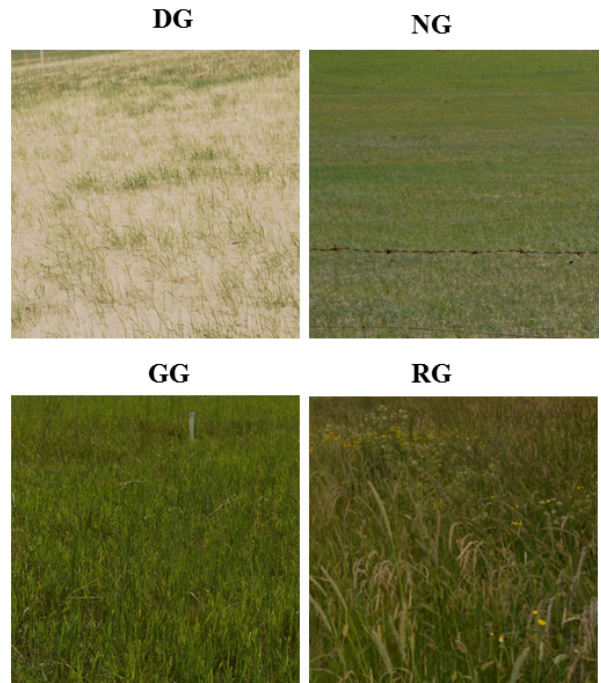
Figure 1. Pictures taking from the study sites, DG: degraded grass- land by overgrazing; NG: native grassland without apparent anthro- pogenic disturbance; GG: groundwater-sustaining grassland; RG: restored grassland from potato